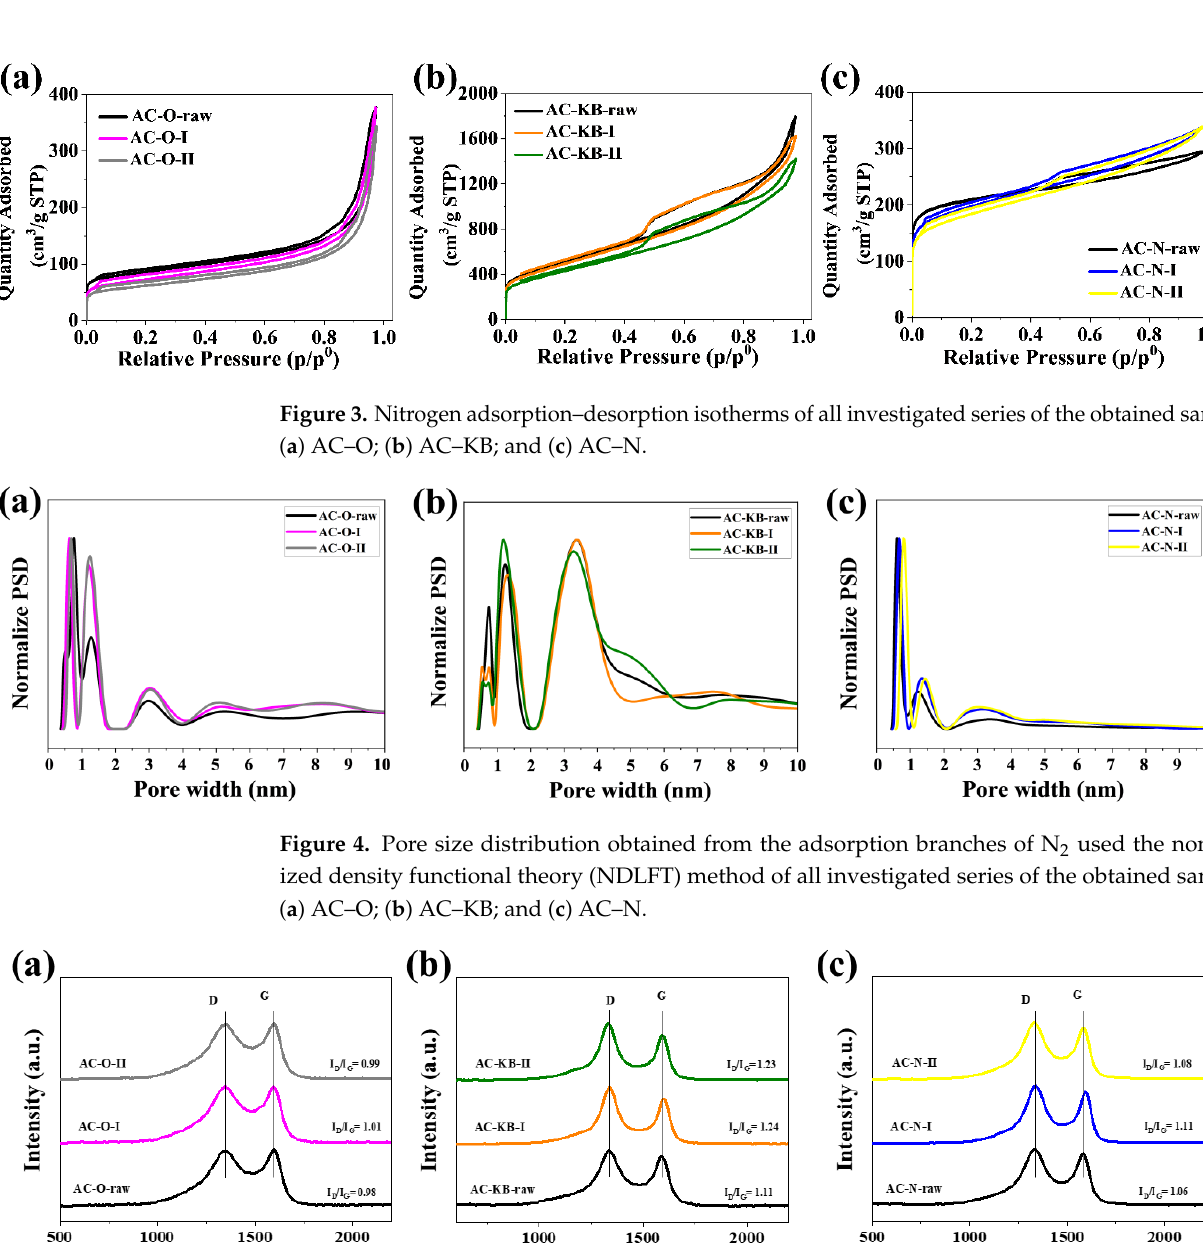
Table 3. D and G band data of Raman spectra.